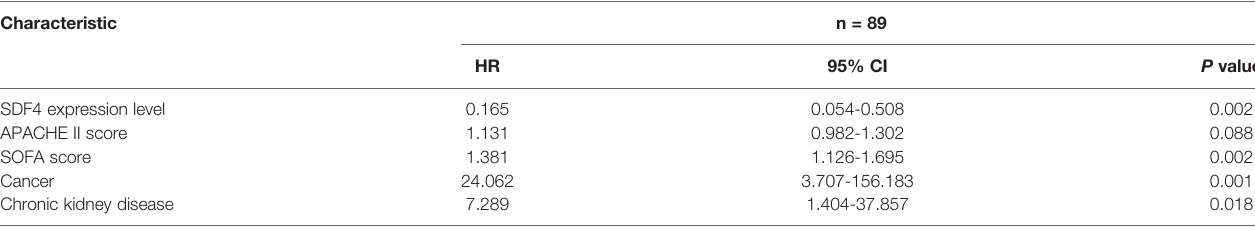
TABLE 2 | Results of multivariate logistic regression modeling.